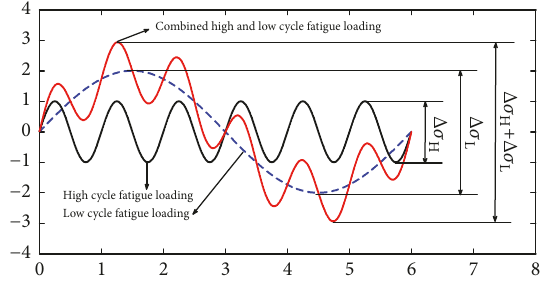
Figure 2: Schematic view of LCL, HCL, and combined cycle